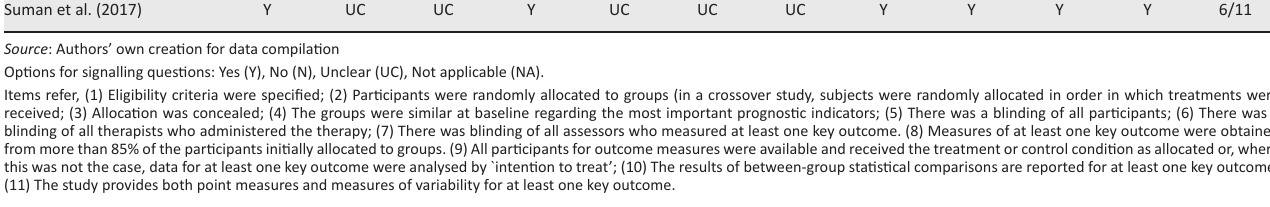
TABLE 2: Evidence appraisal according to the JBI appraisal checklist for quasi-experimental studies. Author